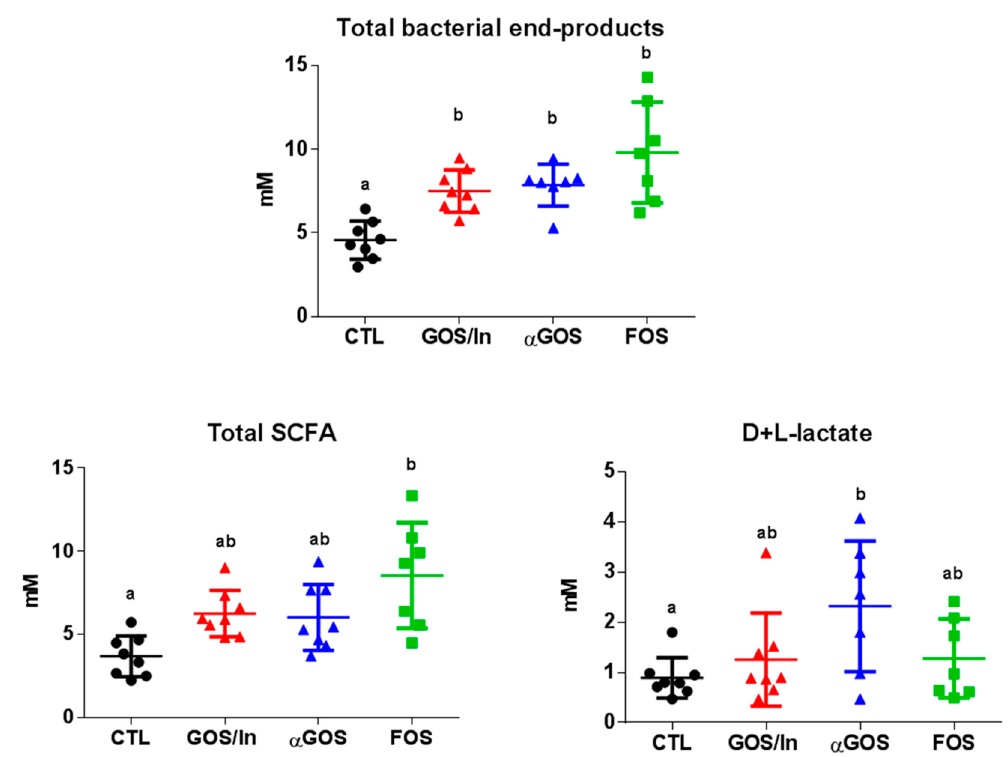
Figure 2. Cecocolonic concentrations of fermentation end-products. Individual, mean and SD values are plotted ( n = 7 to 8 per group). Different letters indicated significant difference ( p < 0.05) between groups.